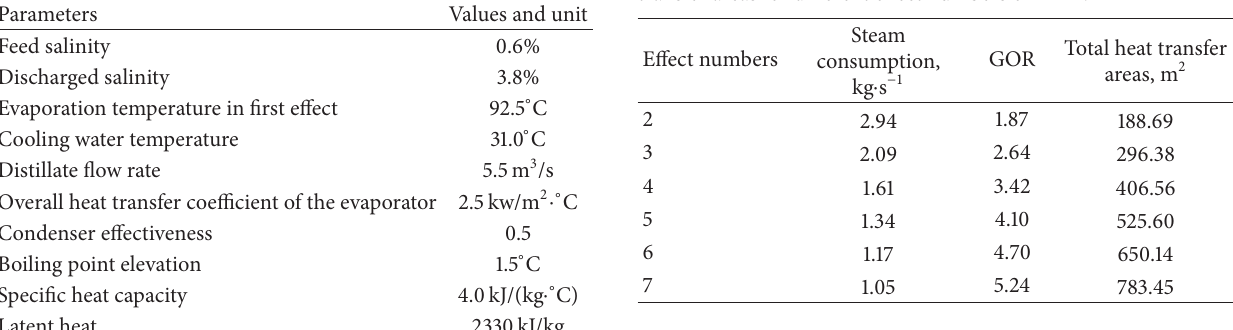
Table 1: The calculation parameters. Table 2: Comparison of steam consumption, GOR, and total heat transfer areas for different effect numbers of